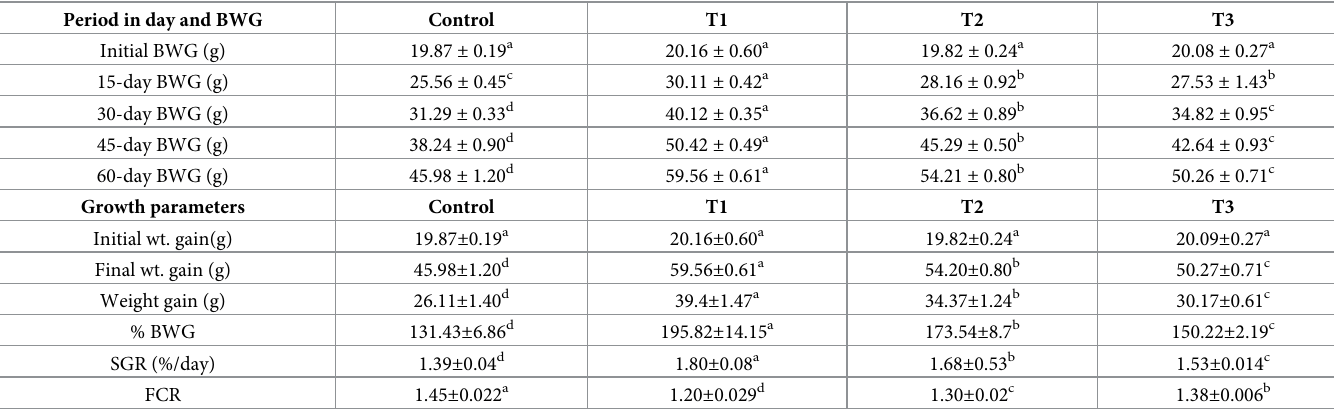
Table 3. Growth parameters of fish fed in indigenous feed ingredients formulated feeds with graded levels of dietary chitosan feeding trial for 60